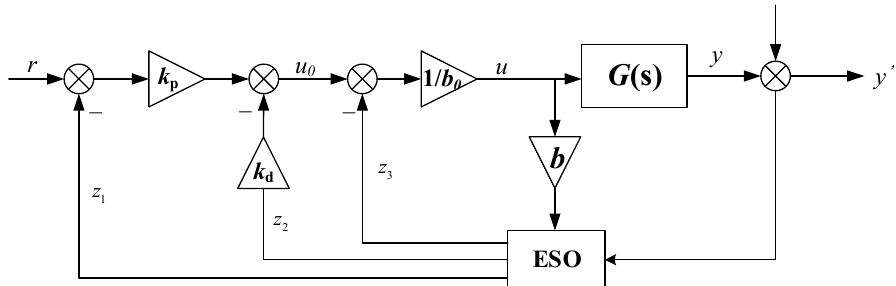
Figure 3. The ADRC block diagram with measurement noise.